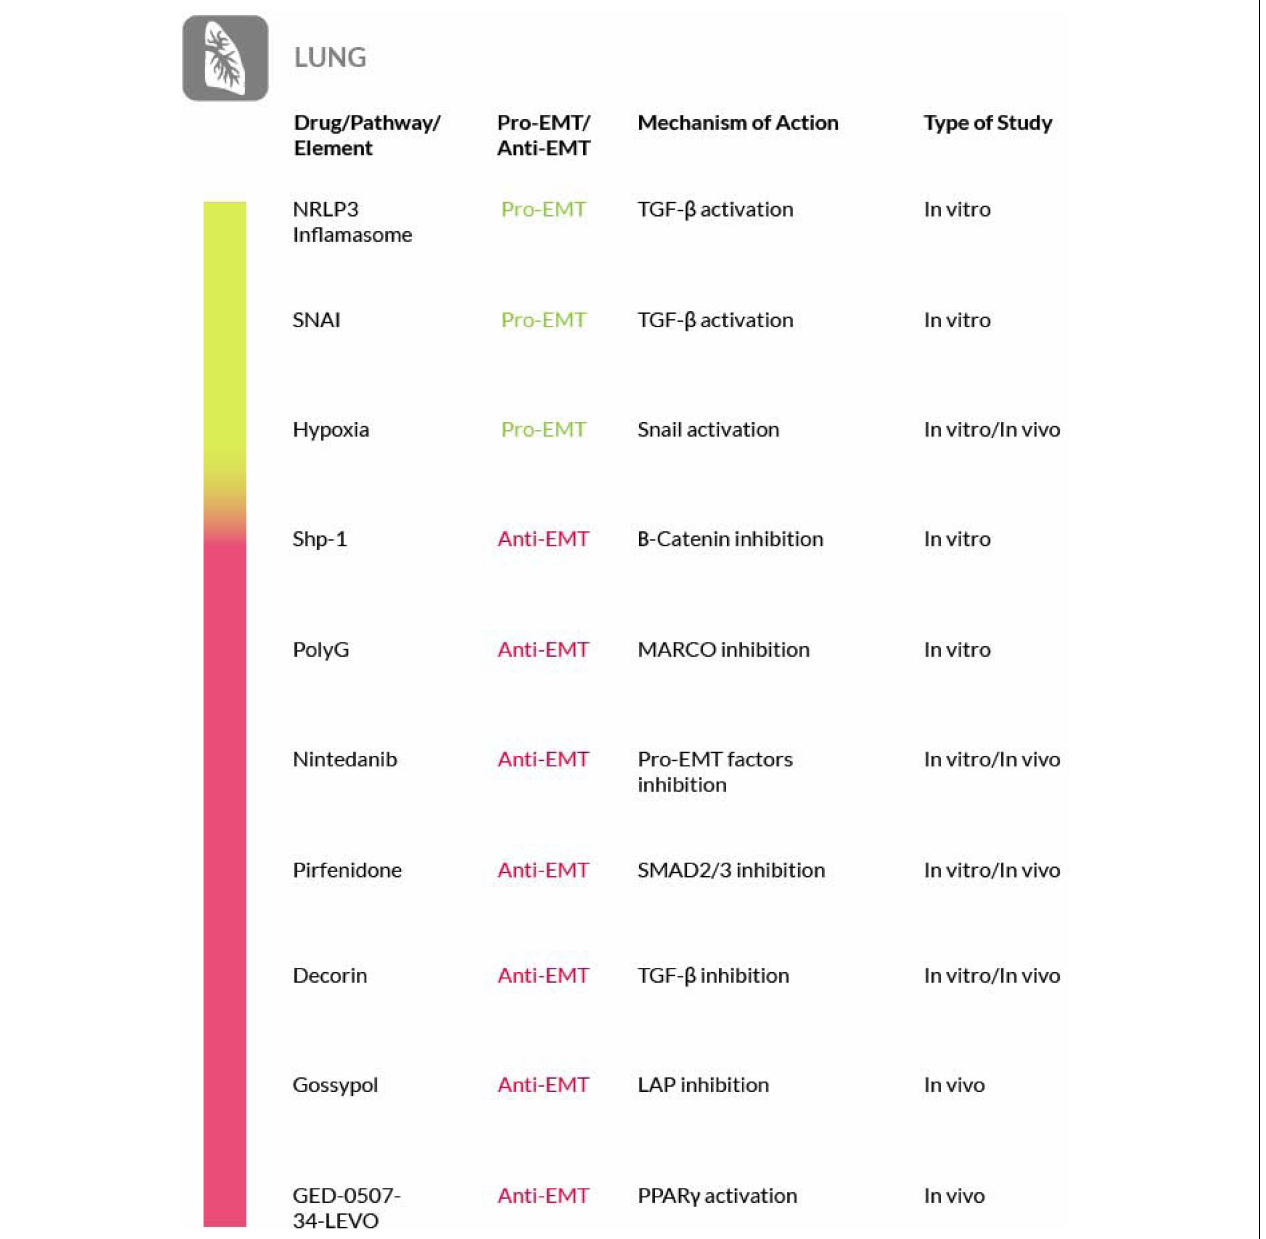
FIGURE 6 | Most relevant molecular mechanisms and possible drugs for the treatment of EMT in pulmonary fibrosis.